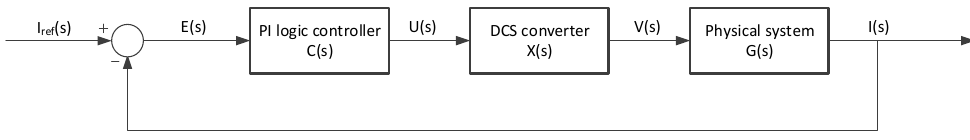
Figure 6. A block diagram of the overall control logic.